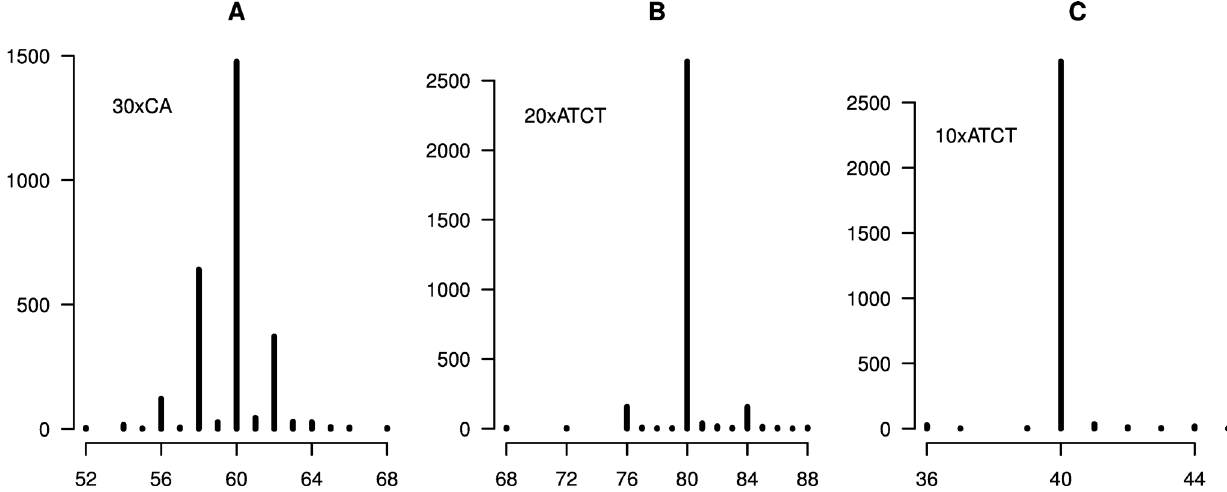
Fig 2. Microsatellite length distributions for no-PCR controls. A. 30xCA. B. 20xATCT. C. 10xATCT (mean of scores from constructs 1 and 2). The y-axes indicate the number of SMRT sequence reads corresponding to the sequence length (bp) indicated on the x-axes. Singleton read lengths have been omitted from the plots for enhanced visualization (see S4, S9, S14 and S19 Figs for full details).